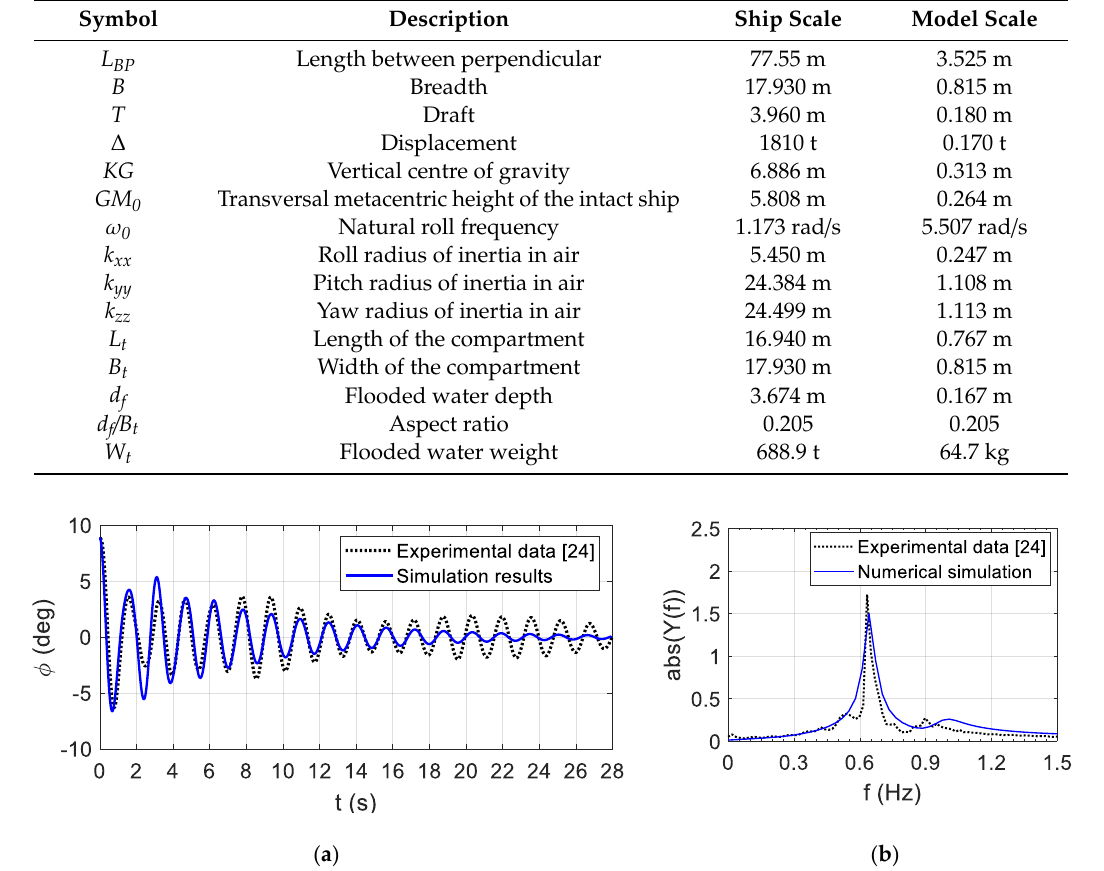
Table 2. Main particulars of the passenger ferry.